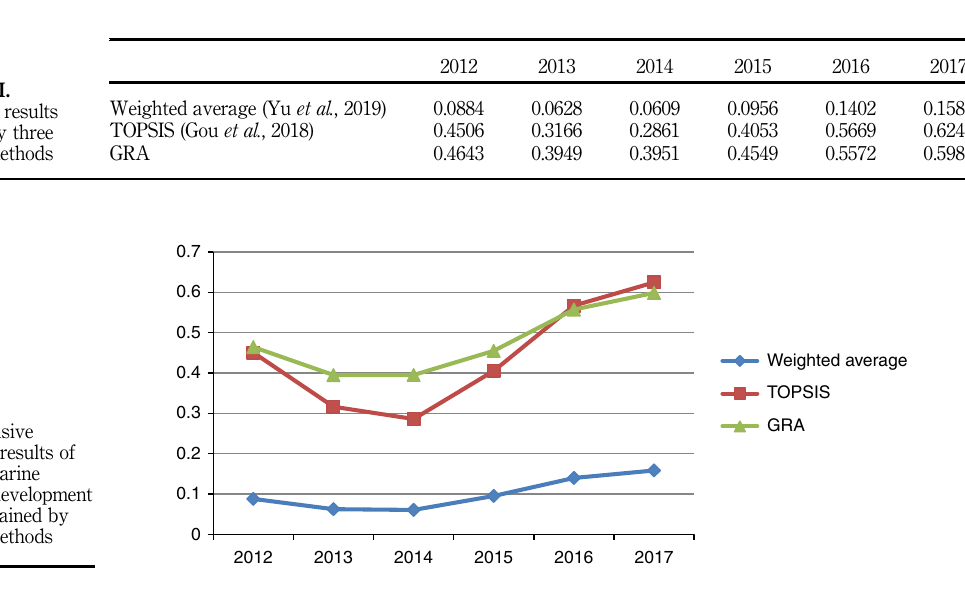
Table VII. Comparisons over the above papers